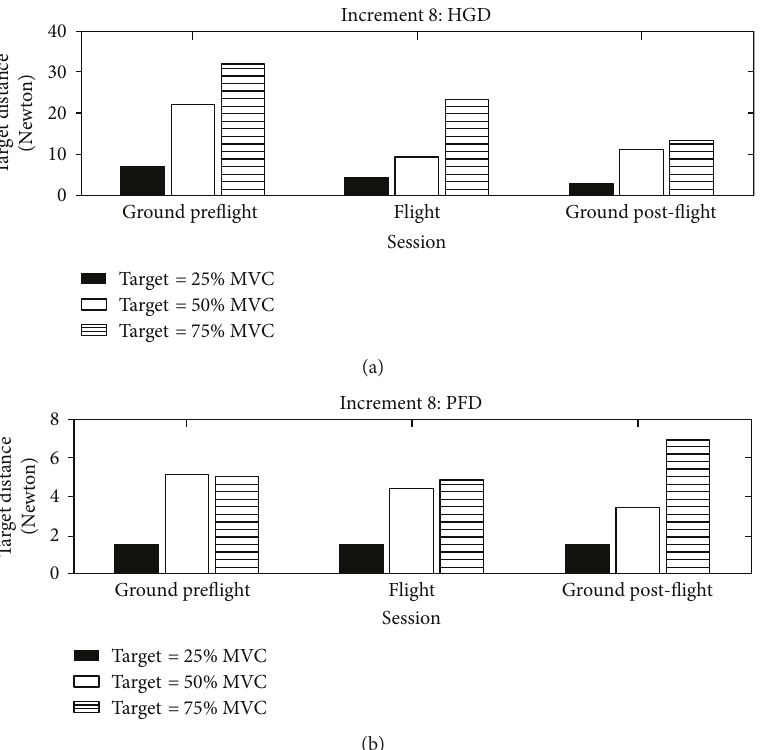
Figure 9: Proprioceptive parameters. (a) Handgrip dynamometer (HGD) target distance (TD). (b) Pinch force dynamometer (PFD) target distance